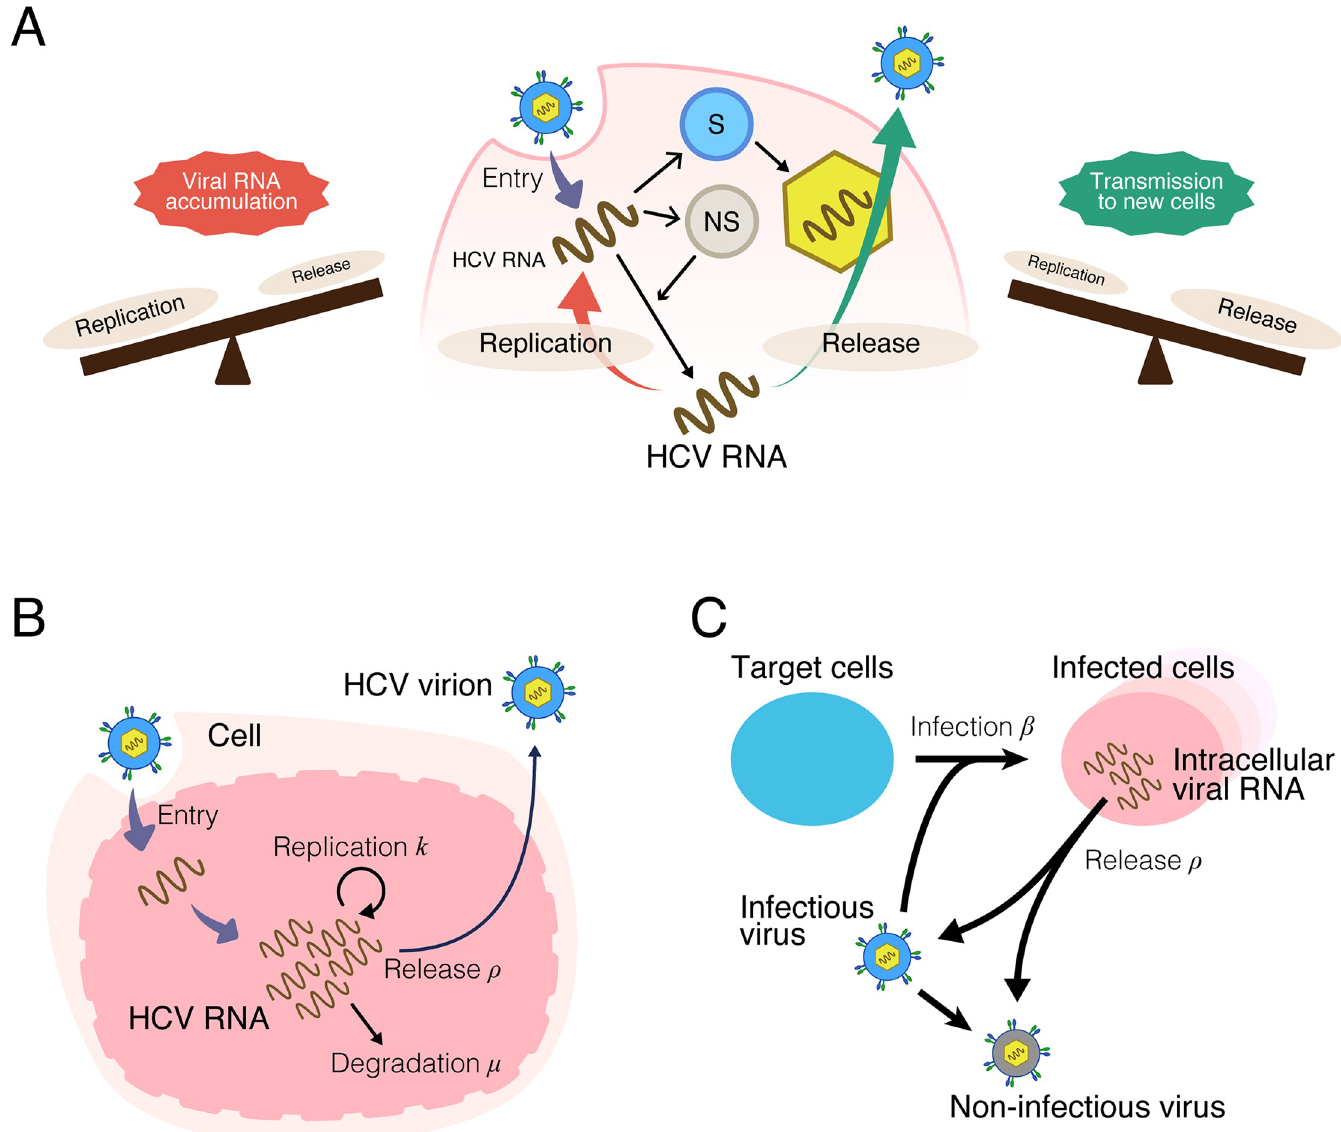
Fig 1. Schematic representation of multiscale HCV infection and mathematical model. (A) Schematic representation of intracellular HCV life cycle and trade-off between viral replication and release of intracellular viral RNA. Viral RNA in cells is translated to produce S and NS proteins. Viral RNA is either amplified through the functions of NS proteins through replication or is assembled with S proteins and released as a progeny virus. If the balance between viral replication and release leans toward replication, intracellular viral RNAs will accumulate. In contrast, high rates of intracellular RNA release will create opportunities for transmission to new cells but will deplete viral RNA in the cell. (B) Modeling the intracellular virus life cycle. Intracellular viral RNA either replicates inside the cell at rate k , is degraded at rate μ , or assembles with viral proteins to be released within HCV virions at rate ρ . (C) Multiscale modeling of intracellular replication and intercellular infection. Target cells are infected by infectious viruses at rate β . HCV, hepatitis C virus; NS protein, nonstructural protein; S protein, structural protein.